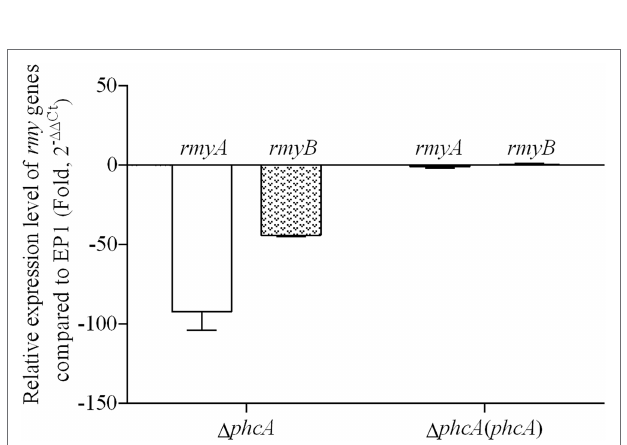
FIGURE 2 | qRT-PCR analysis of rmyA and rmyB in wide type strain EP1, phcA deletion mutant ( Δ phcA ), and complementary strain Δ phcA ( phcA ) (OD 600 = 1.0). The results were calculated as 2 – ΔΔ Ct , – ΔΔ Ct = − ( Δ Ct mutant – Δ Ct wt ). Three biological repeats (independent cultures) and three technical repeats were done to calculate and compare the values. Mean values of all experiments were averaged with SD (error bars) by using the GraphPad Prism 6.0